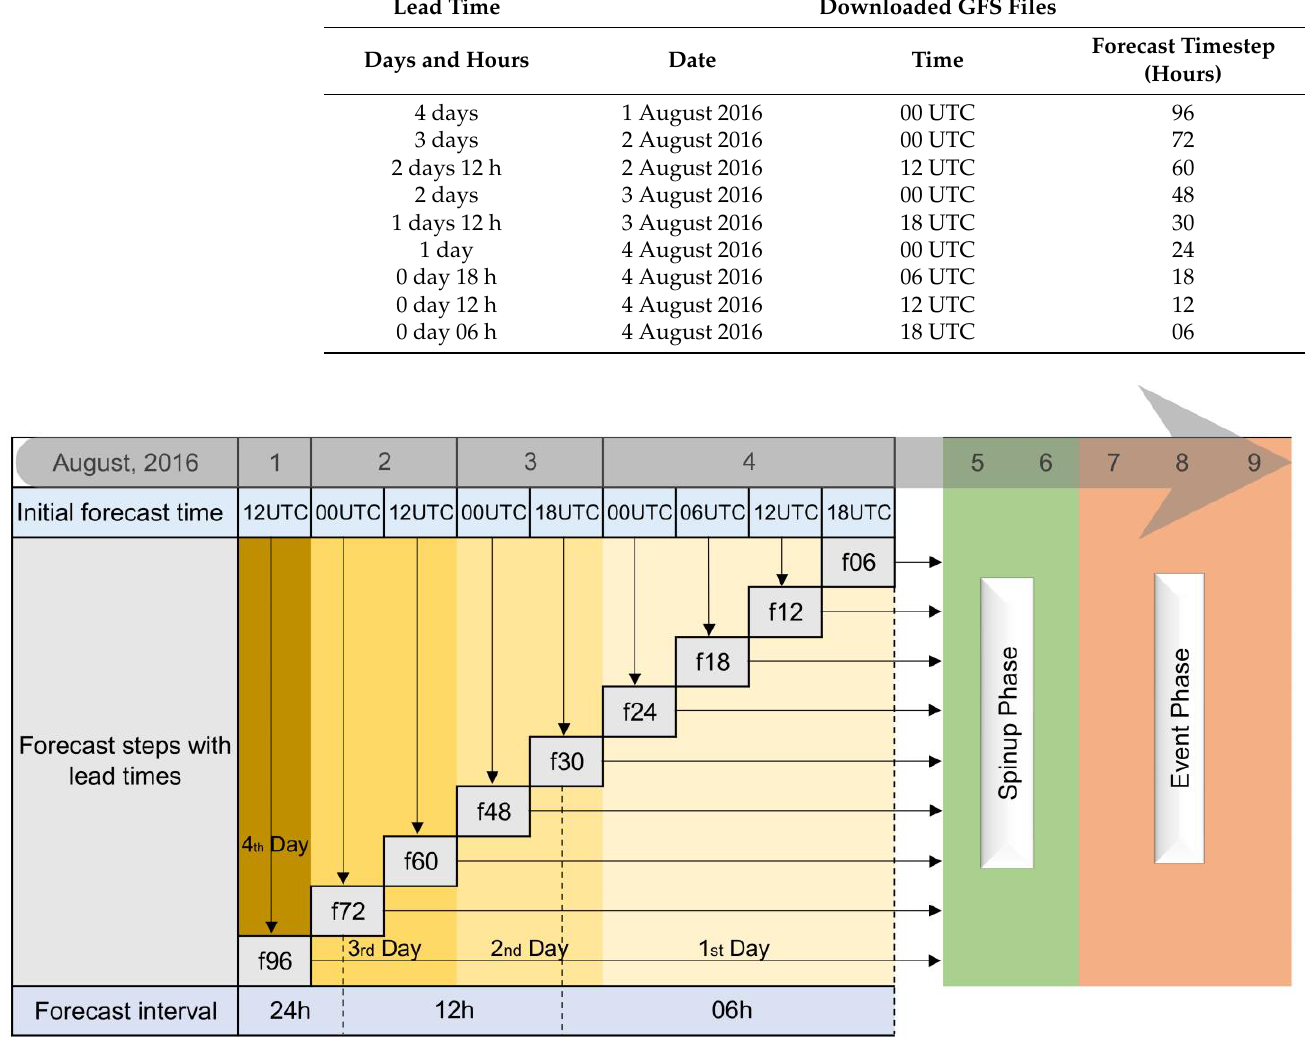
Figure 3. Graphical description of GFS data structure for selected peak event in the CRB.